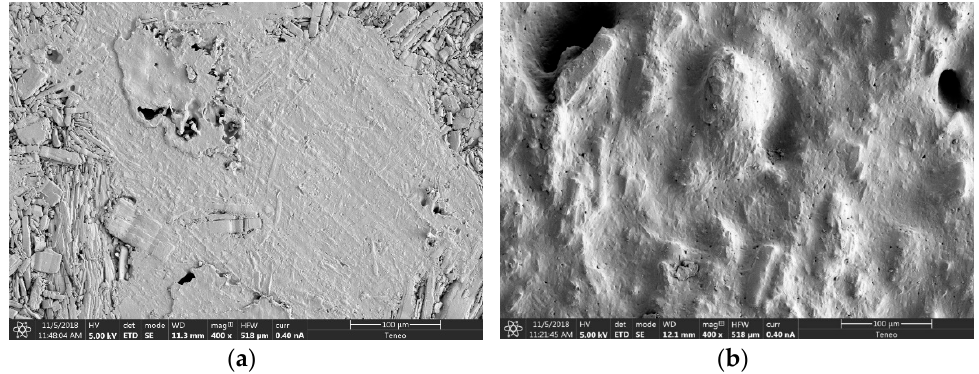
Figure 7. SEM images, magnification 400×, of PBS_CL tablets obtained by USAC (47/53% v/v) ( a ) and filaments obtained by HME (45/55% v/v) ( b ) before release of drug. These results are concordant with those previously reported by Galdón et al. [28].